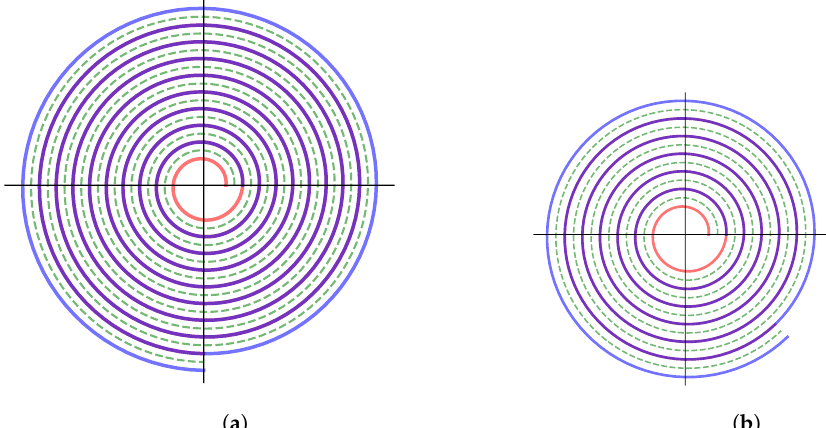
Figure 3. Investigated SPHE geometry configurations: ( a ) Configuration investigated by Strenger et al. [9], N t = 8.75. ( b ) Two-module SPHE geometry with equivalent area to the SPHE of Strenger et al. [9], N t =